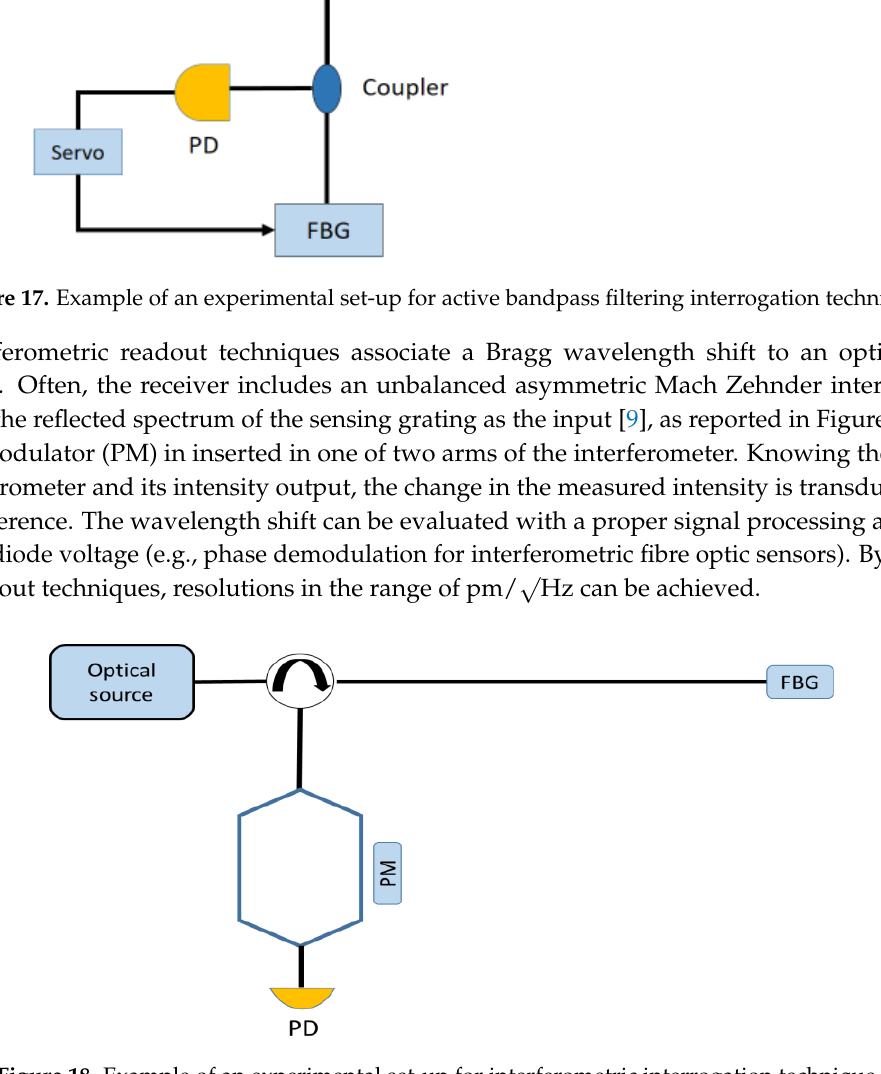
Figure 18. Example of an experimental set-up for interferometric interrogation technique.